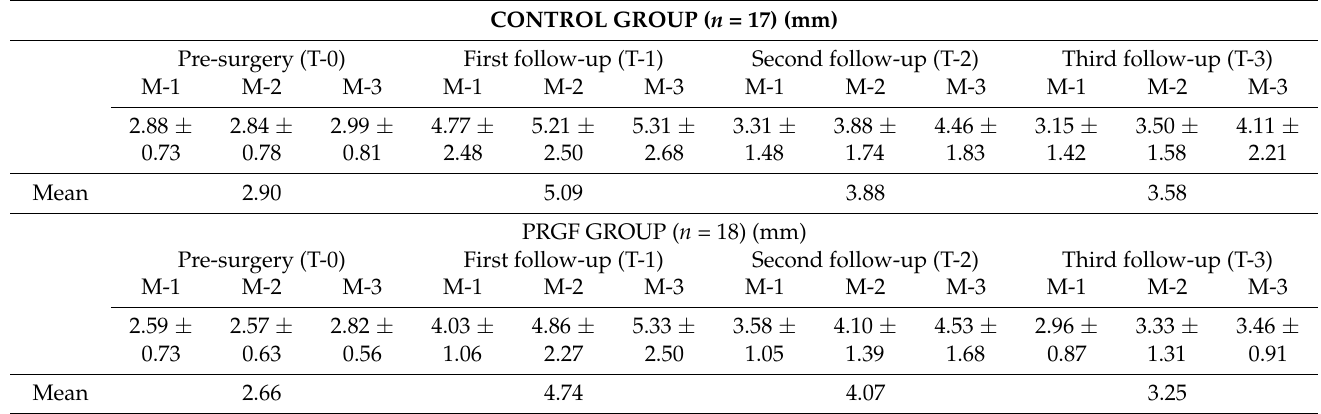
Table 1. Means and standard derivations of patellar ligament thickening at the different